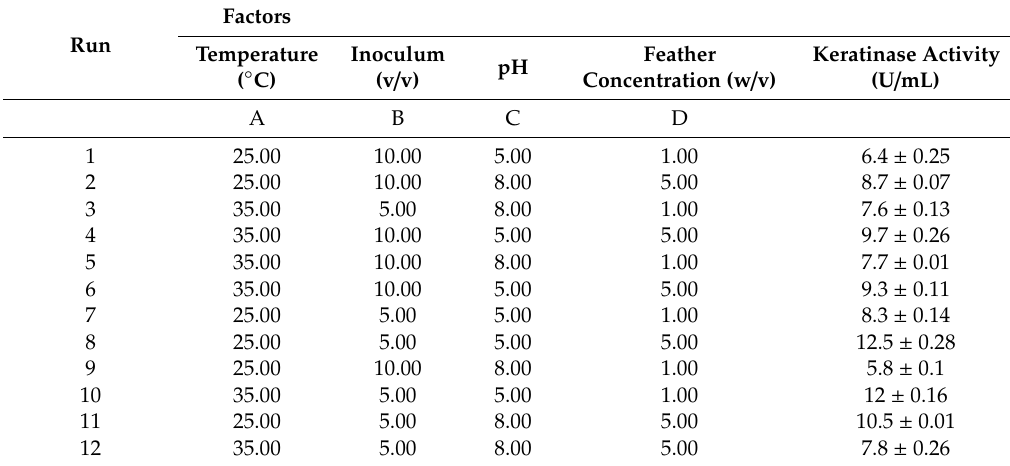
Table 2. Prescreening of significant parameters using Plackett-Burman design matrix with keratinase activity as the response ( ± standard deviation, n =